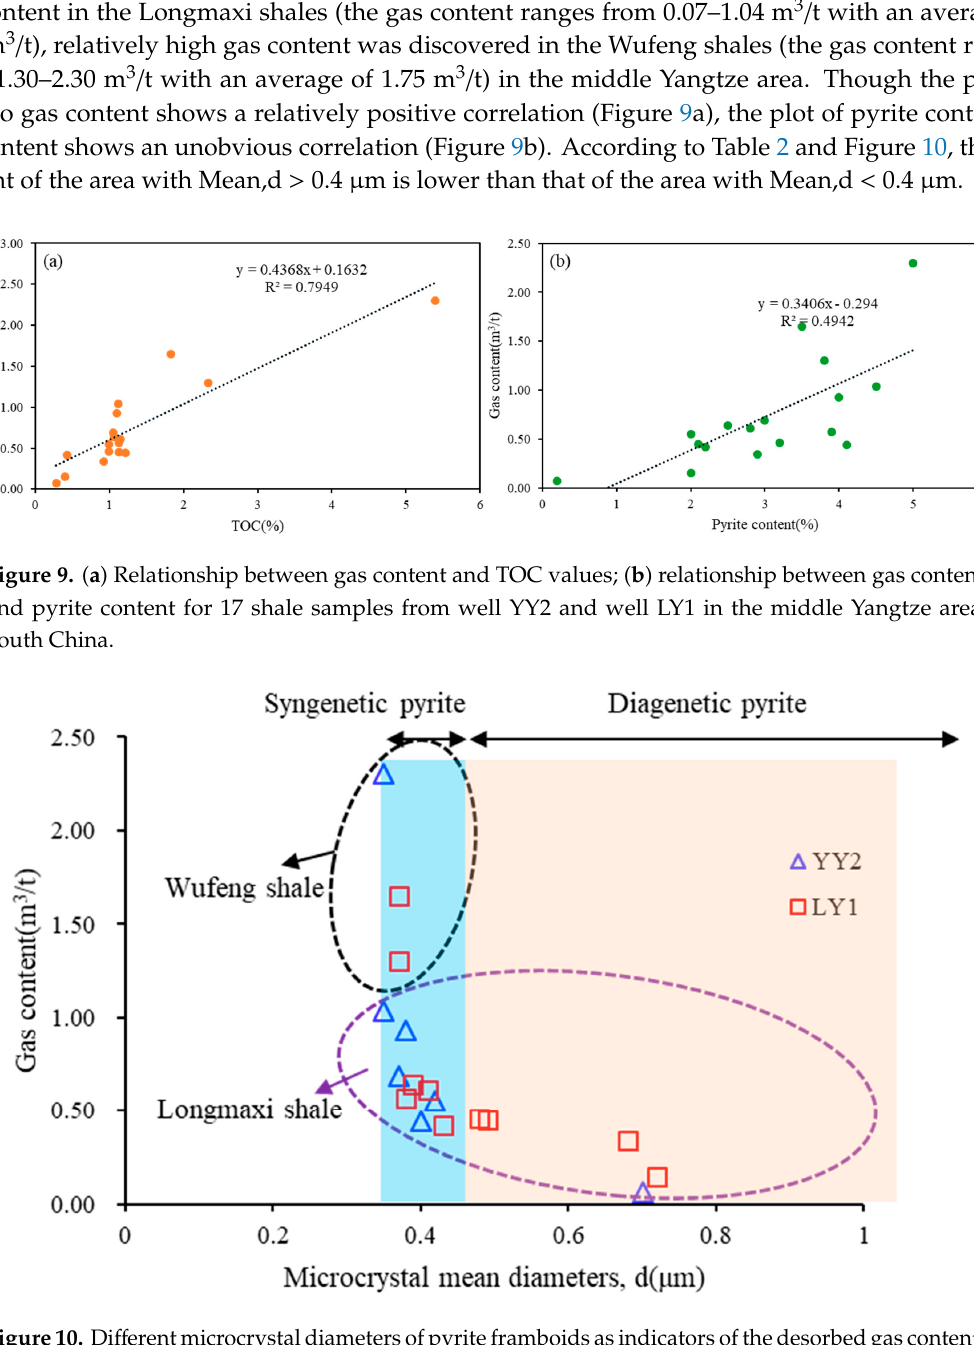
Figure 10. Di ff erent microcrystal diameters of pyrite framboids as indicators of the desorbed gas content. For 10 gas samples from well YY2 and Well LY1, the δ 13 C 1 values range from − 38.4% (cid:24) to − 30.2% (cid:24) , while the δ 13 C 2 values range from − 41.5% (cid:24) to − 35.5% (cid:24) (Table 3). Additionally, the δ 13 C 1 (% (cid:24) )- δ 13 C 2 (% (cid:24) ) values range from 2.90% (cid:24) to 5.50% (cid:24) . As the microcrystals continue to grow larger than 0.4 µ m,